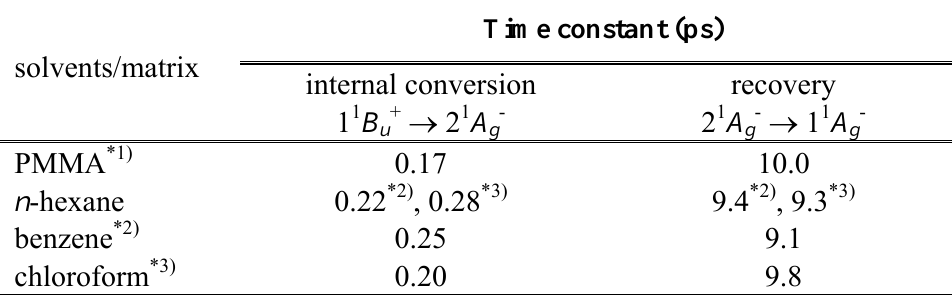
Table 1. The estimated time constants of the internal conversion from 1 1 B and the recovery from 2 1 A the values in different solvents are also